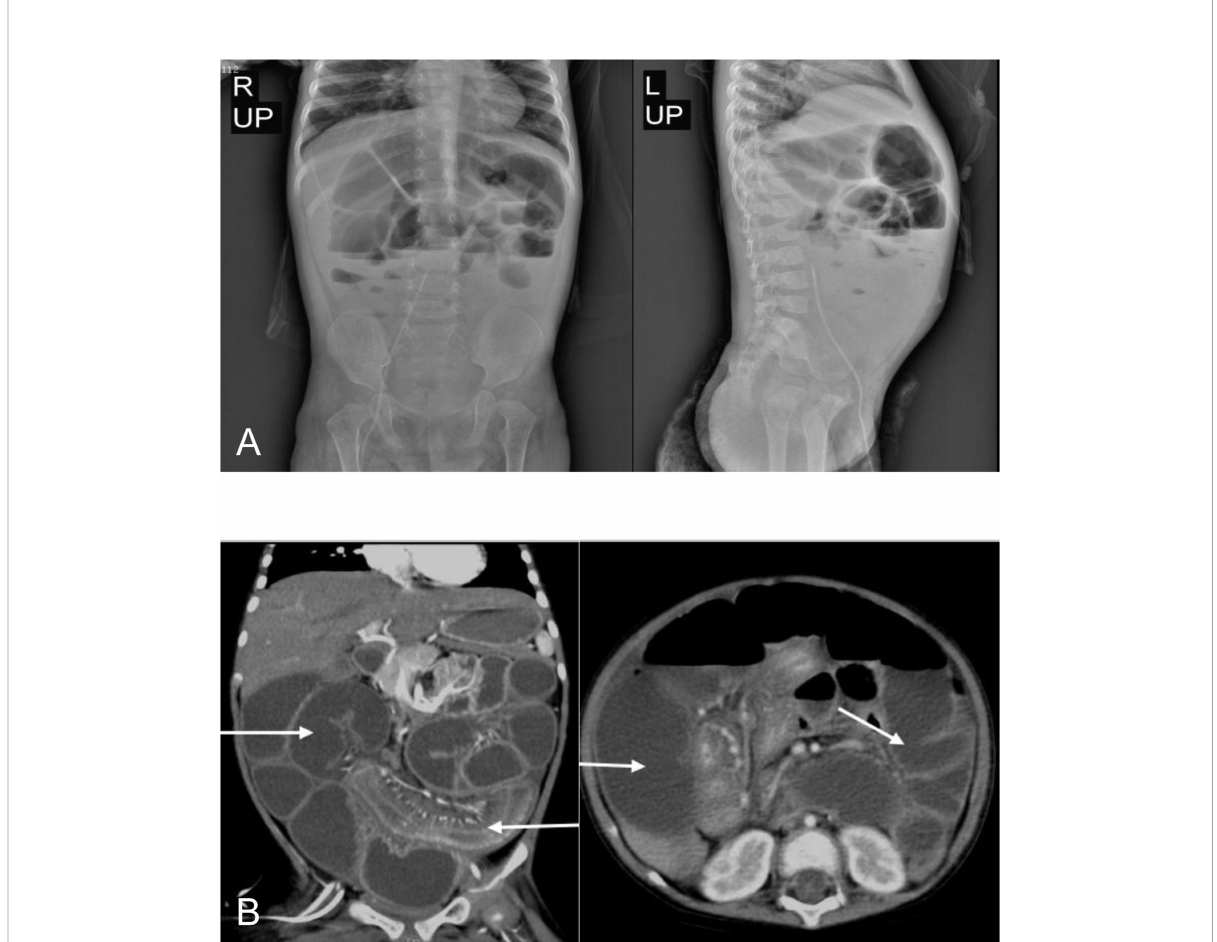
FIGURE 2 Bowel dilation, bowel wall thickening, and stenosis in the patient. (A) Abdominal radiograph showed bowel dilation with a gas − liquid level. (B) CT scan showed bowel dilation, thickening of the bowel wall, and small bowel